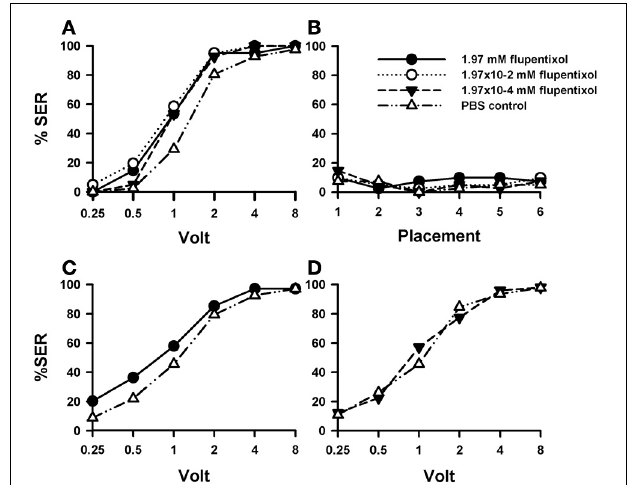
FIGURE 3 | Effects of DA blocking on aversive responsiveness. Three different groups of bees were injected with three different concentrations of the DA antagonist flupentixol (1.97mM: n = 41; 1.97 × 10 − 2 mM: n = 41; 1.97 × 10 − 4 mM: n = 41). A fourth group was injected with PBS as a control ( n = 41). Sting responsiveness was measured in response to increasing voltages during shock trials (A) and during placement trials (B) . All three flupentixol concentrations induced an increase of responsiveness to electric shocks compared to PBS controls [ F ( 3 , 160 ) = 5 . 46, p < 0 . 01]. No differences were found between flupentixol-injected and PBS-injected bees in the placement trials. (C) In a replicate of this experiment, another group of bees was injected with the highest flupentixol concentration (1.97mM: n = 69) and their response to increasing voltages was measured. An increase in responsiveness to shocks with respect of the PBS control was verified ( n = 68) [ F ( 1 , 135 ) = 4 . 07, p < 0 . 05). Thus, DA signaling plays a significant inhibiting role in sting responsiveness to noxious stimuli as its blockade increased shock sensitivity. (D) In a further replicate the